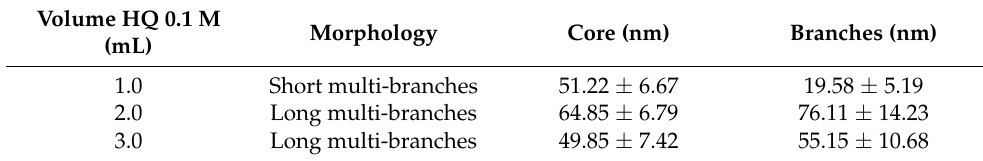
Figure 6. TEM images of GNS prepared in various HQ 0.1 M volume—( a ) 1.0 mL, ( b ) 2.0 mL, and ( c ) 3.0 mL. Table 6. The influence of HQ on morphology, average core and branches of GNS.